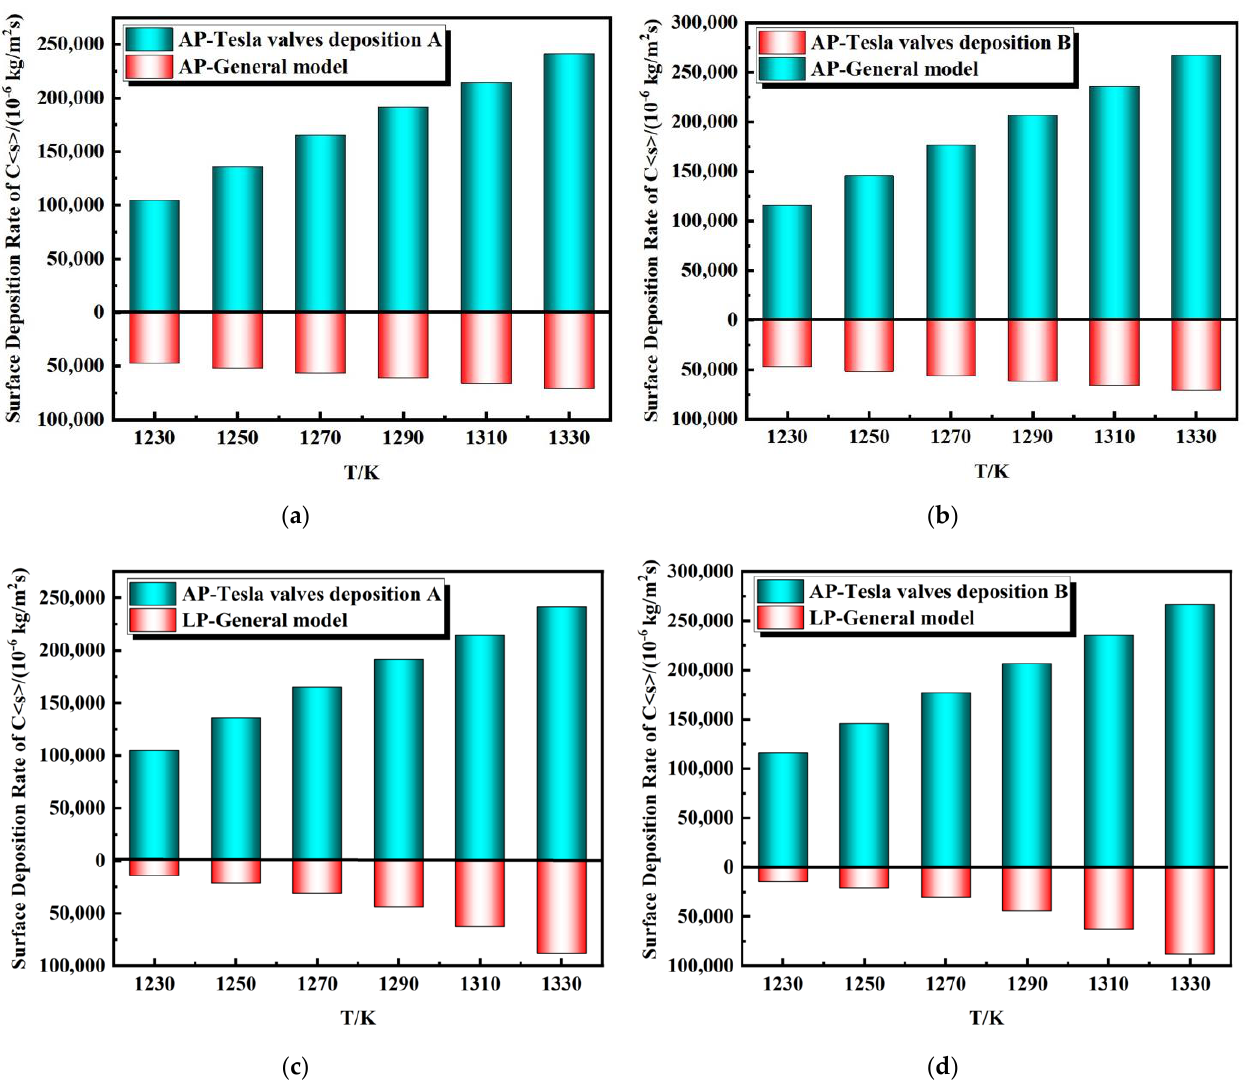
Figure 11. Atmospheric and low surface deposition rate of c
with different temperature in reverse flow: ( a ) AP deposition A; ( b ) AP deposition B; ( c ) LP deposition A; ( d ) LP deposition B.